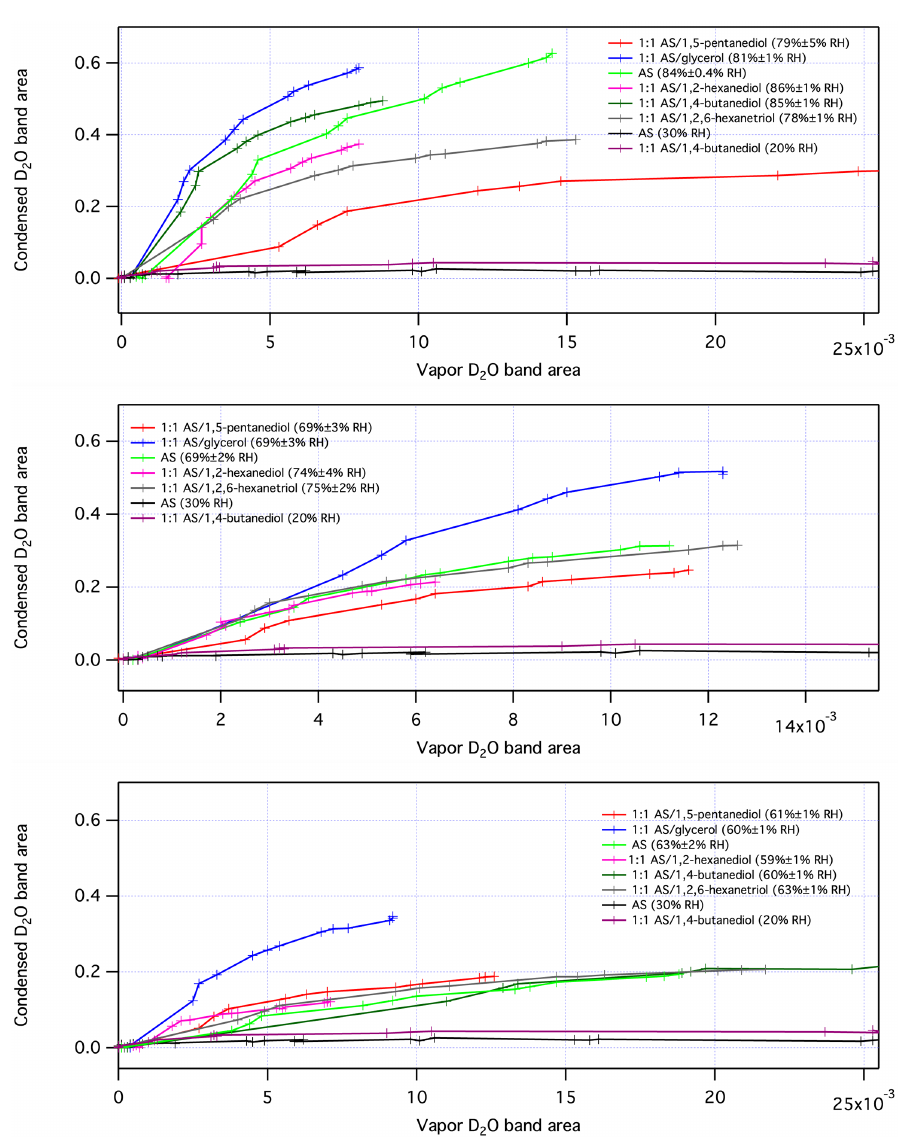
Figure 9. Gas-phase exchange experiments for organic / (NH 4 ) 2 SO 4 mixtures in three RH ranges. Data for pure ammonium sulfate at 30% RH, a crystalline solid, is plotted for reference. No change in the condensed D 2 O band area is seen in only the two control cases: ammonium sulfate at 30% RH and a 1 : 1 (NH 4 ) 2 SO 4 / 1,4-butanediol mixture at 20% RH, both of which are below their efflorescence point (i.e., they contain no condensed-phase water). For all particles containing condensed water, an exchange of D 2 O vapor is apparent. Liquid–liquid phase separation does not exclude water diffusion into the aqueous